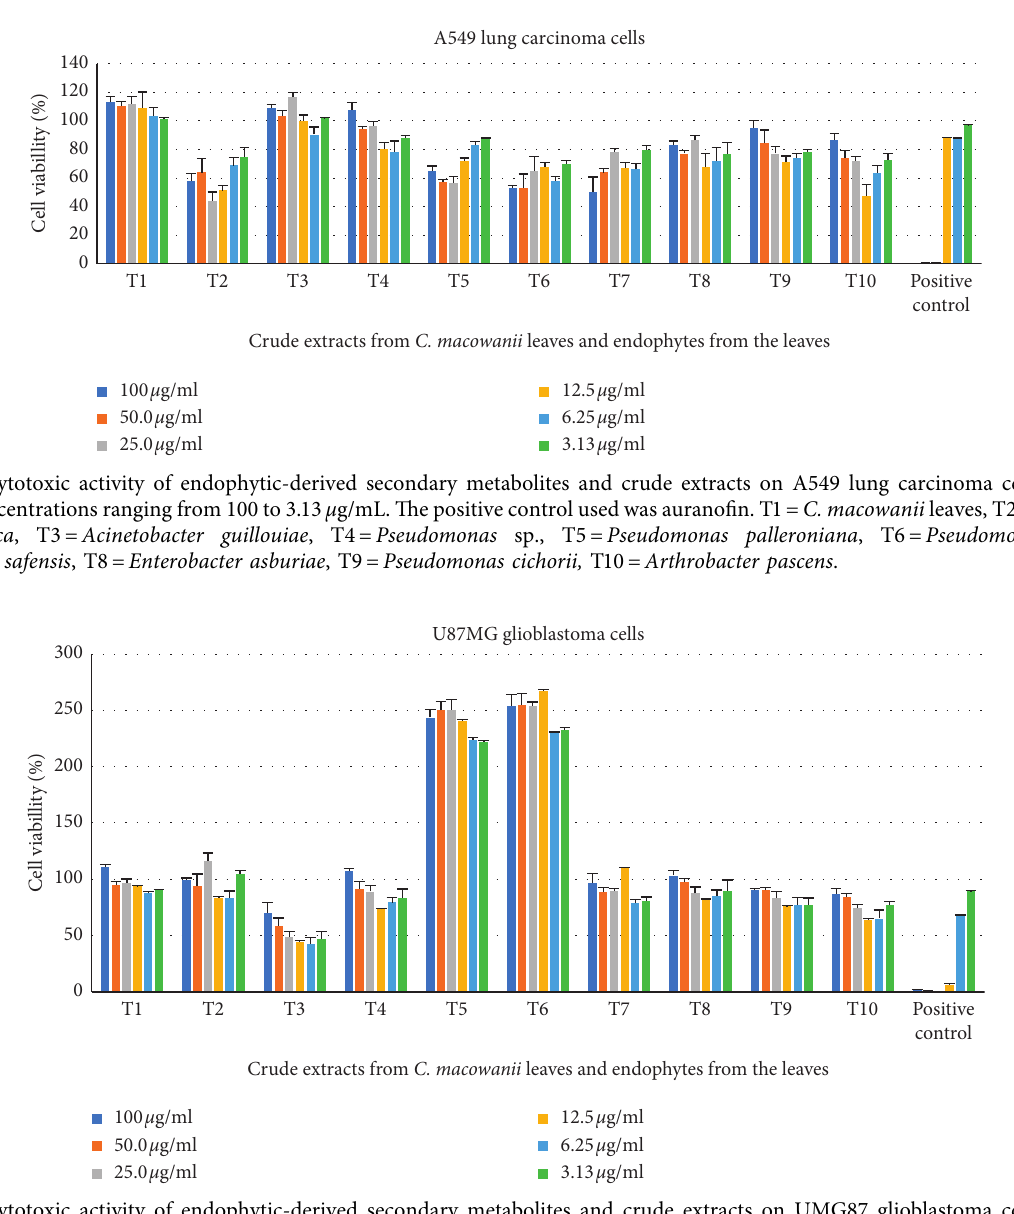
Figure 3: Cytotoxic activity of endophytic-derived secondary metabolites and crude extracts on UMG87 glioblastoma cells tested at different concentrations ranging from 100 to 3.13 μ g/mL. The positive control used was auranofin. T1 � C. macowanii leaves, T2 � Raoultella ornithinolytica , T3 � Acinetobacter guillouiae , T4 � Pseudomonas sp., T5 � Pseudomonas palleroniana , T6 � Pseudomonas putida , T7 � Bacillus safensis , T8 � Enterobacter asburiae , T9 � Pseudomonas cichorii, T10 � Arthrobacter pascens